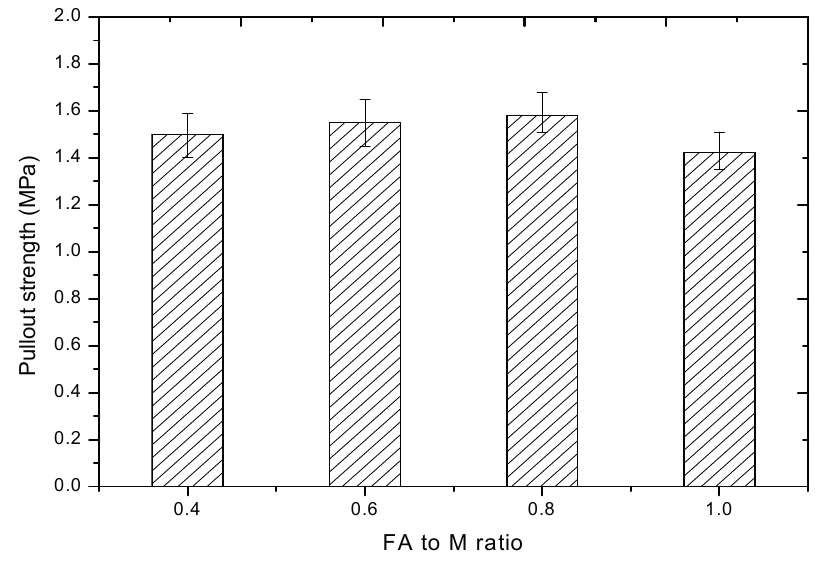
Figure 9. The pullout strength of carbon fiber composites with different FA additions.